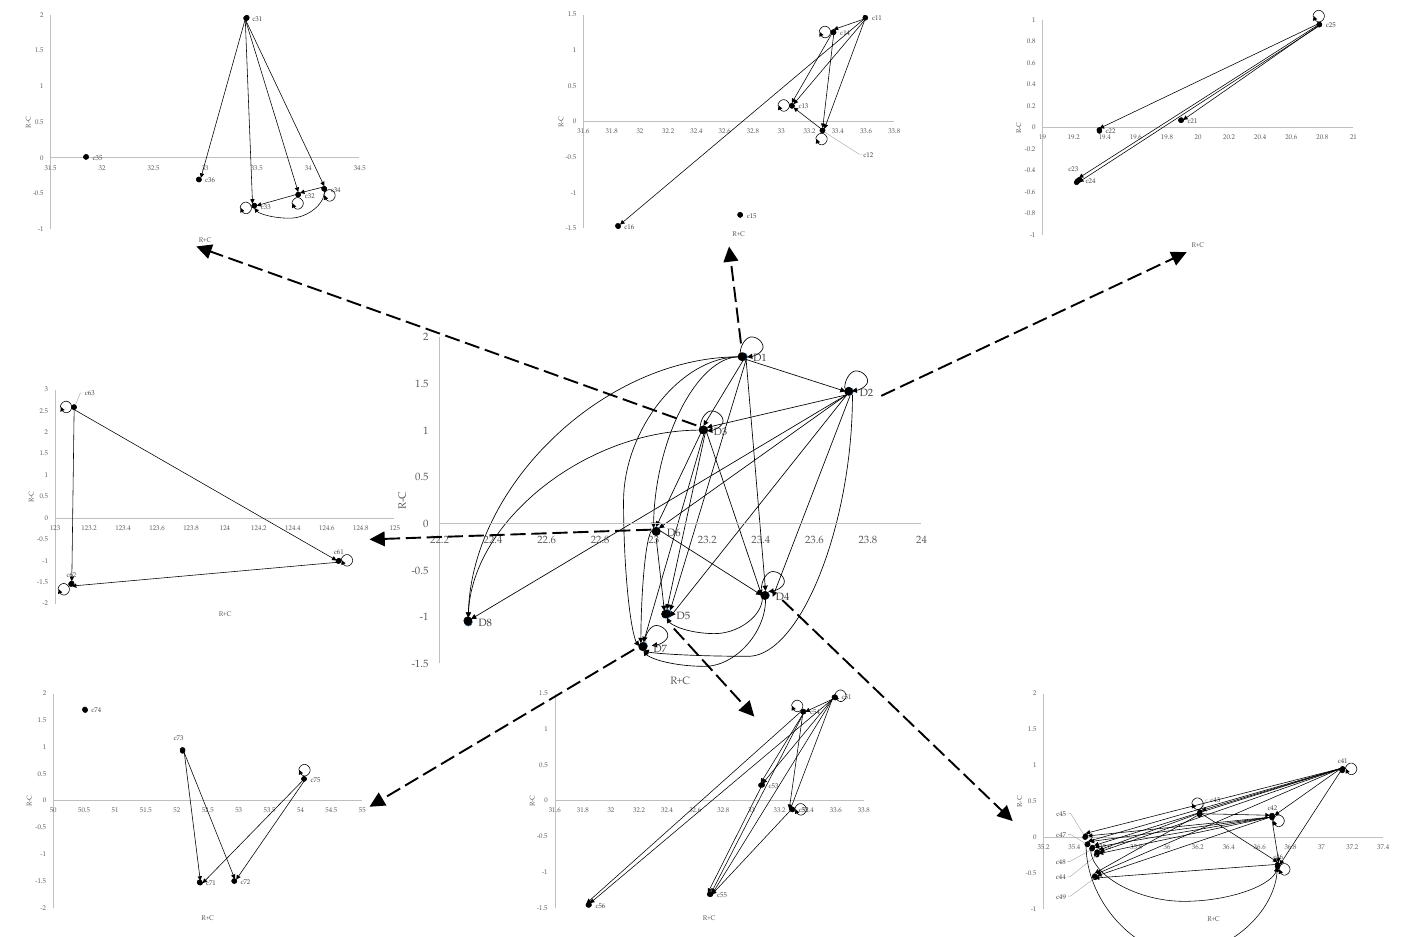
Figure 3. The Causal Relationship Structure of Each Dimension and Its Criteria.